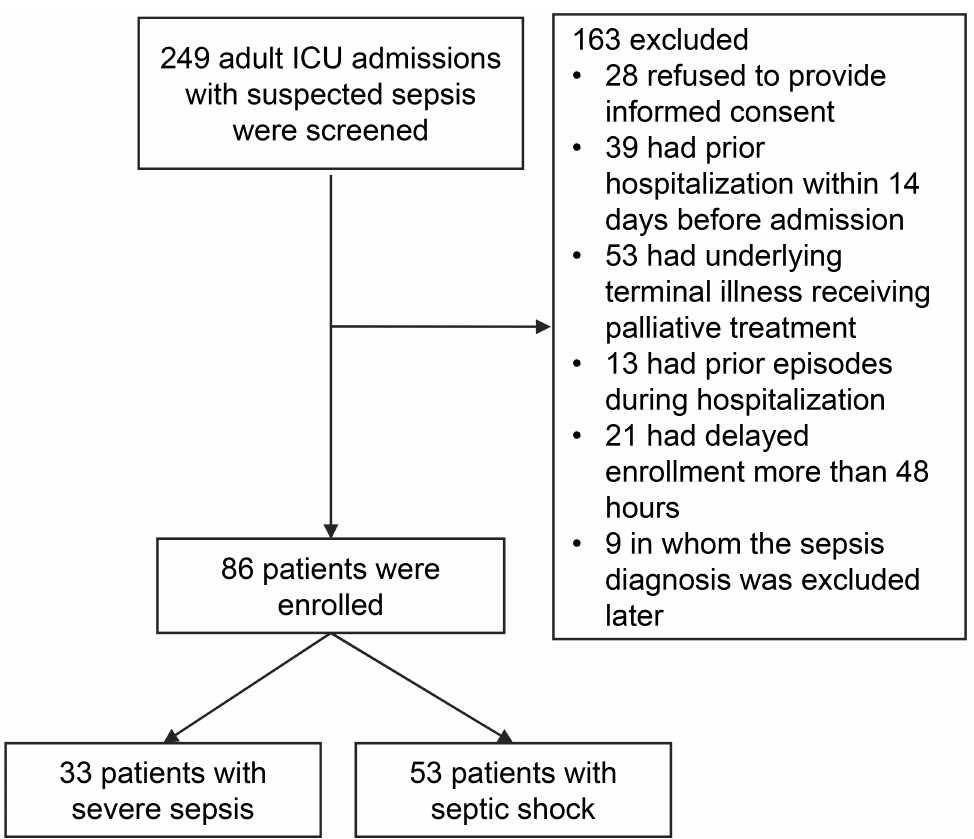
Fig 1. Flow chart of patient inclusion and